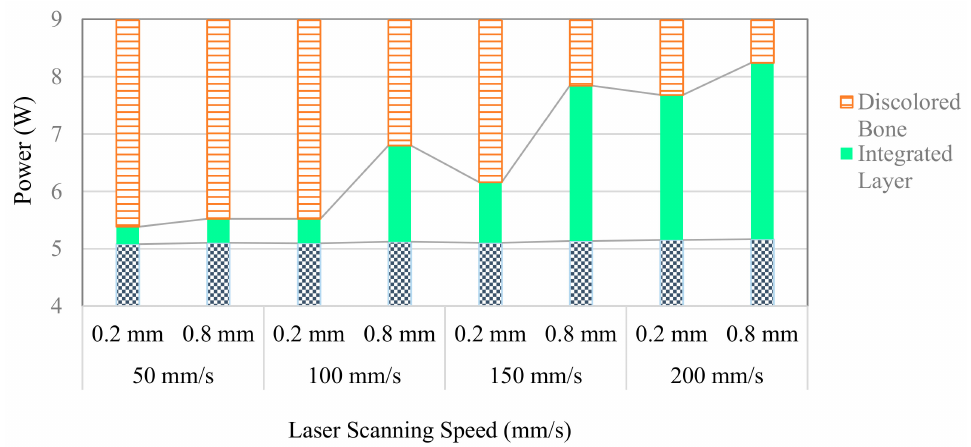
Figure 6. The comparison of safe operational range to processing DBM / PCL for two laser spot sizes (0.2 mm, 0.8 mm) and a range of scanning speeds.